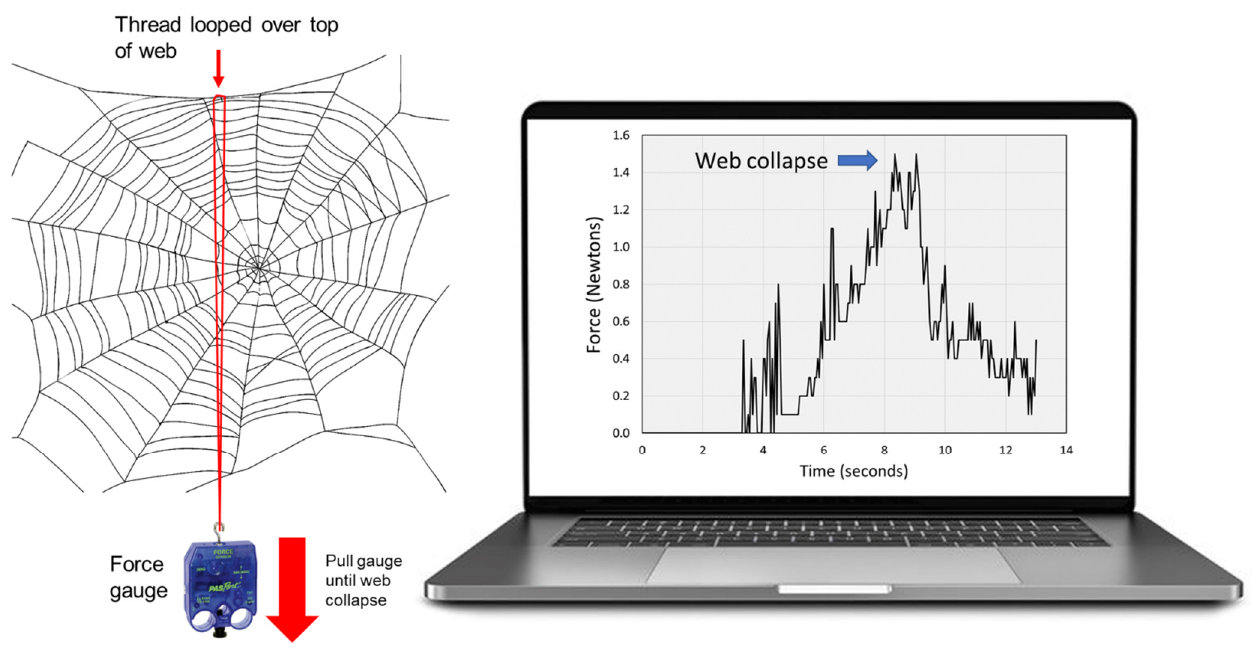
Figure 3. Schematic diagram showing how jor¯o web strength was measured, on 10 webs in Oconee Co., Georgia. One of the authors (Davis) looped a light thread around the middle of a given web, then tied the lower end of the loop to a handheld, digital force gauge. The gauge was pulled downward until the web collapsed, and the peak force (in Newtons) at which the web broke was recorded on a laptop. Raw force data from one web test is shown for illustration.